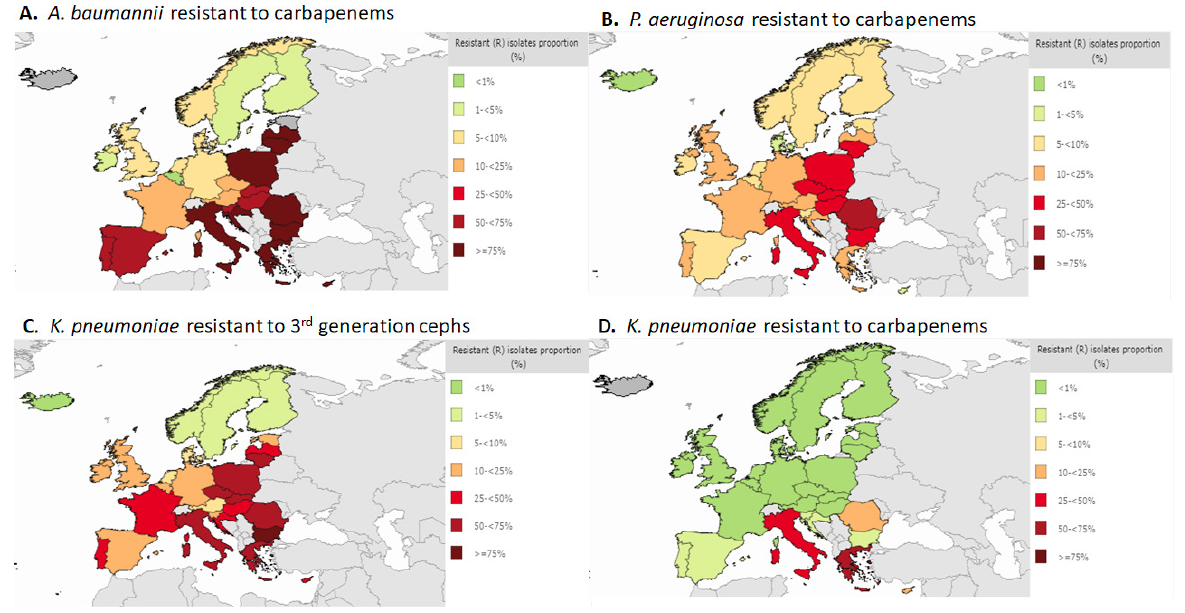
Figure 4. Percentage of antimicrobial resistance in Europe in 2015 [ 18